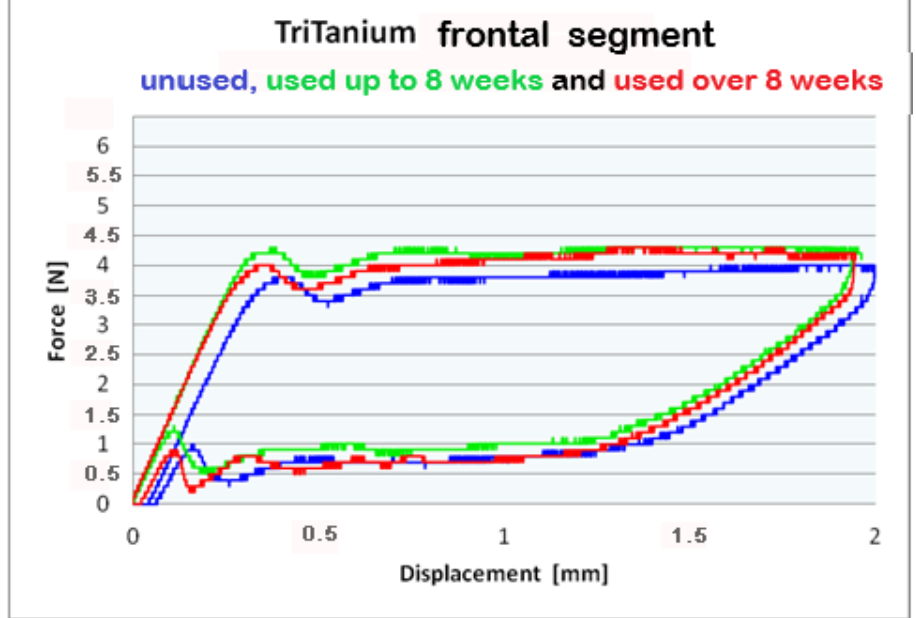
Figure 5. Combined force/deformation curve graphs for period G 0 (blue), G 1 (green) , G 2 (red), frontal segment for the TriTanium ® archwire.